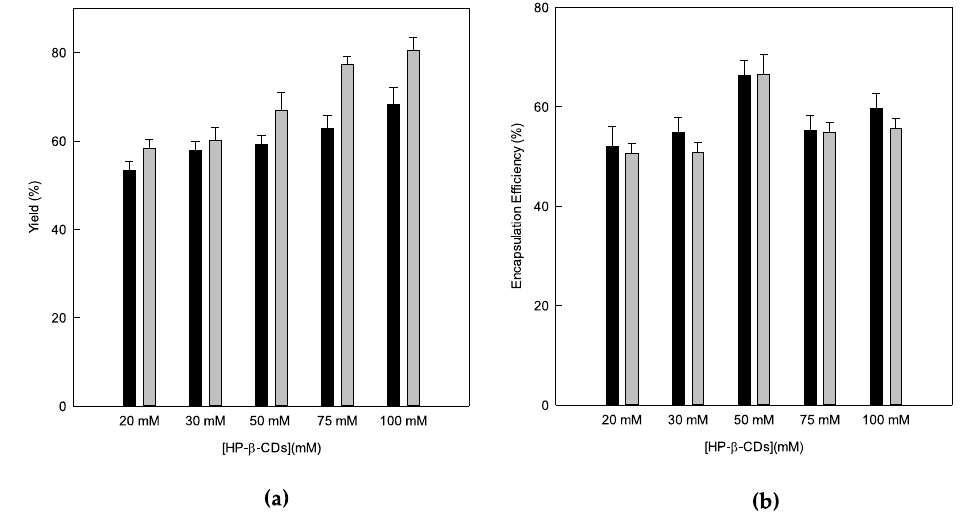
Figure 5. ( a ) Drying process yield (g kg − 1 ) and ( b ) encapsulation efficiency (g kg − 1 ) of carvacrol-HP- β -CDs complexes, prepared via US (grey bars) and MWI (black bars). The experiments were performed in triplicate.